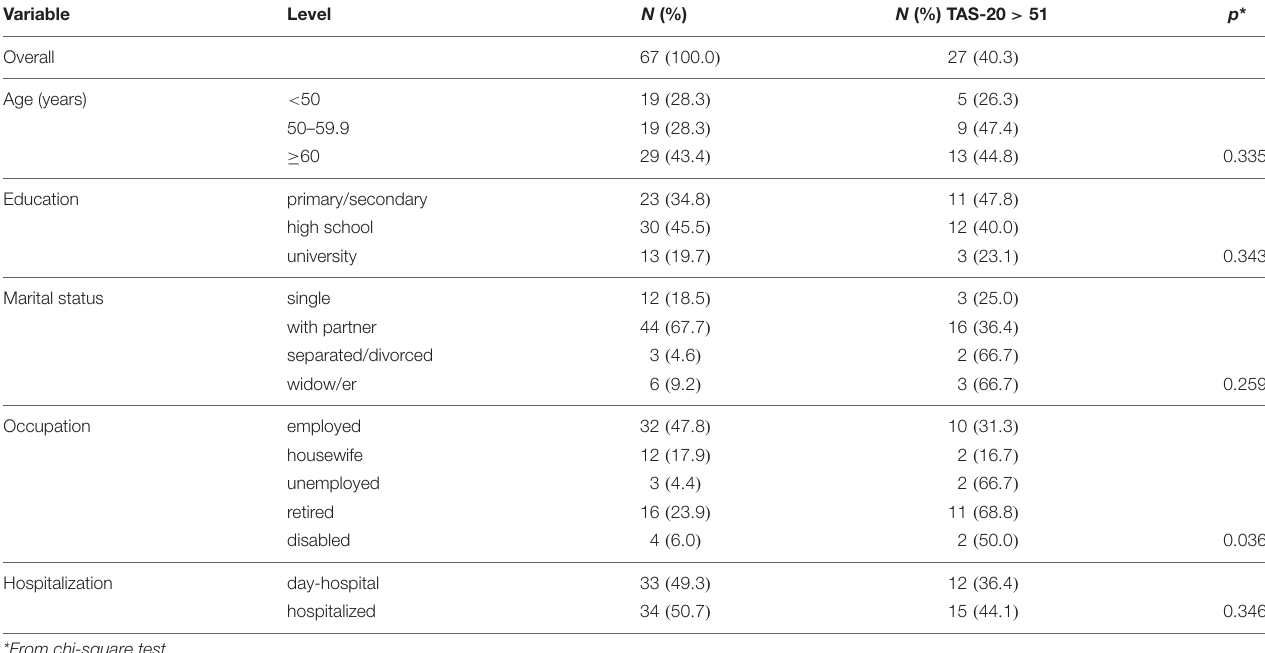
TABLE 1 | Percentage of patients with alexithymia or borderline alexithymia according to the 20-item Toronto Alexithymia scale (TAS-20). Variable